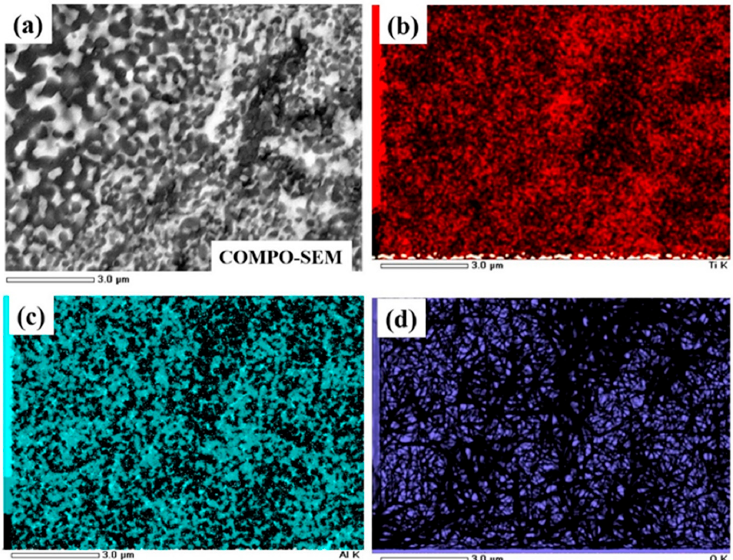
Figure 5. ( a ) COMPO-SEM microphotograph of Al 2 O 3 /Ti 3 Al composite with EDS mapping photos of corresponding areas, ( b ) titanium (Ti), ( c ) aluminum (Al), ( d ) oxygen (O) of samples sintered at 850 °C.